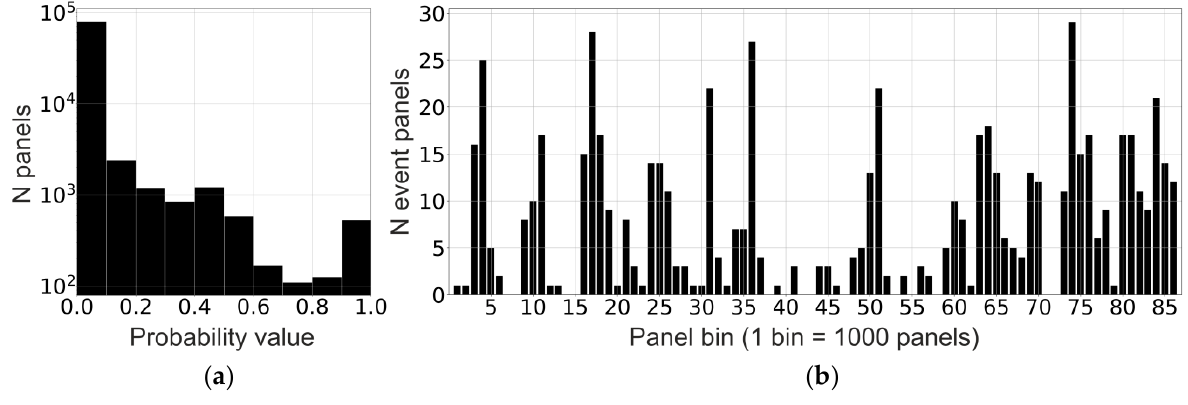
Figure 5. ( a ) Probability distribution of the body–wave occurrence in all analyzed noise panels provided by the ensemble of CNN-based models. ( b ) Distribution of the detected body–wave events (i.e., noise panels that were assigned with a probability estimate larger than 0.8).